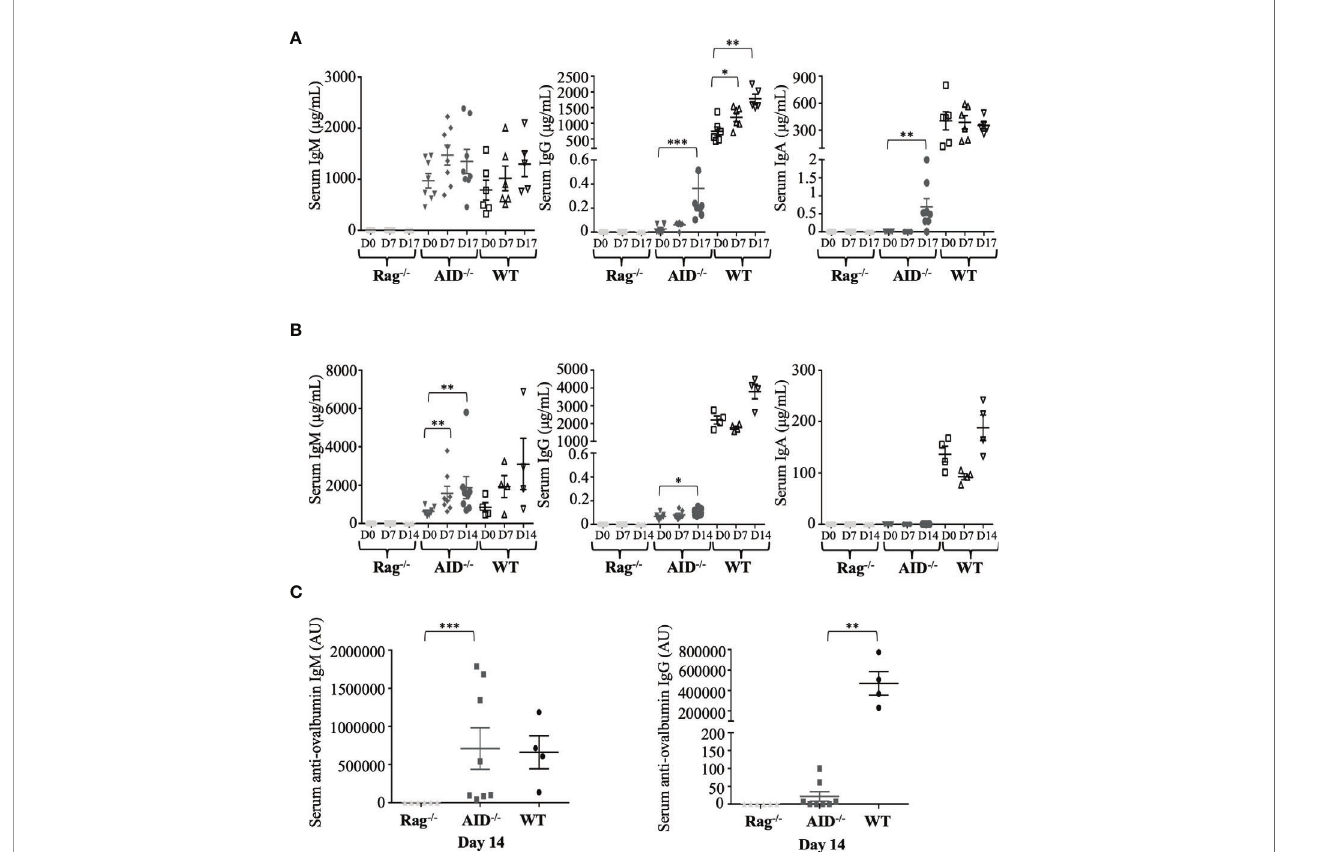
FIGURE 2 | Dynamic induction of Ig production after mouse immunization. (A) Total IgM, IgG, and IgA concentrations in serum from immunized mice were evaluated by ELISA before and at 17 days after immunization with sheep red blood cells (samples were taken at days 0, 7, and 17, with booster immunization at day 7). (B) Total IgM, G, and A concentrations in serum from immunized mice were evaluated by ELISA before and at 14 days after ovalbumin (OVA) immunization at days 0, 7, and 14. (C) Ag-speci fi c IgG1 and IgM antibodies were evaluated by ELISA after 14 days of intraperitoneal OVA immunization. The data in (A) represent mean concentrations ± SEM from fi ve RAG-de fi cient, eight activation-induced deaminase (AID)-de fi cient, and six wild-type (WT) mice. Mann – Whitney test was used for signi fi cance. The data in (B, C) represent mean concentrations ± SEM from six RAG-de fi cient, eight AID-de fi cient mice, and four WT mice. Mann – Whitney test was used for signi fi cance. *p < 0.05; **p < 0.01; ***p <